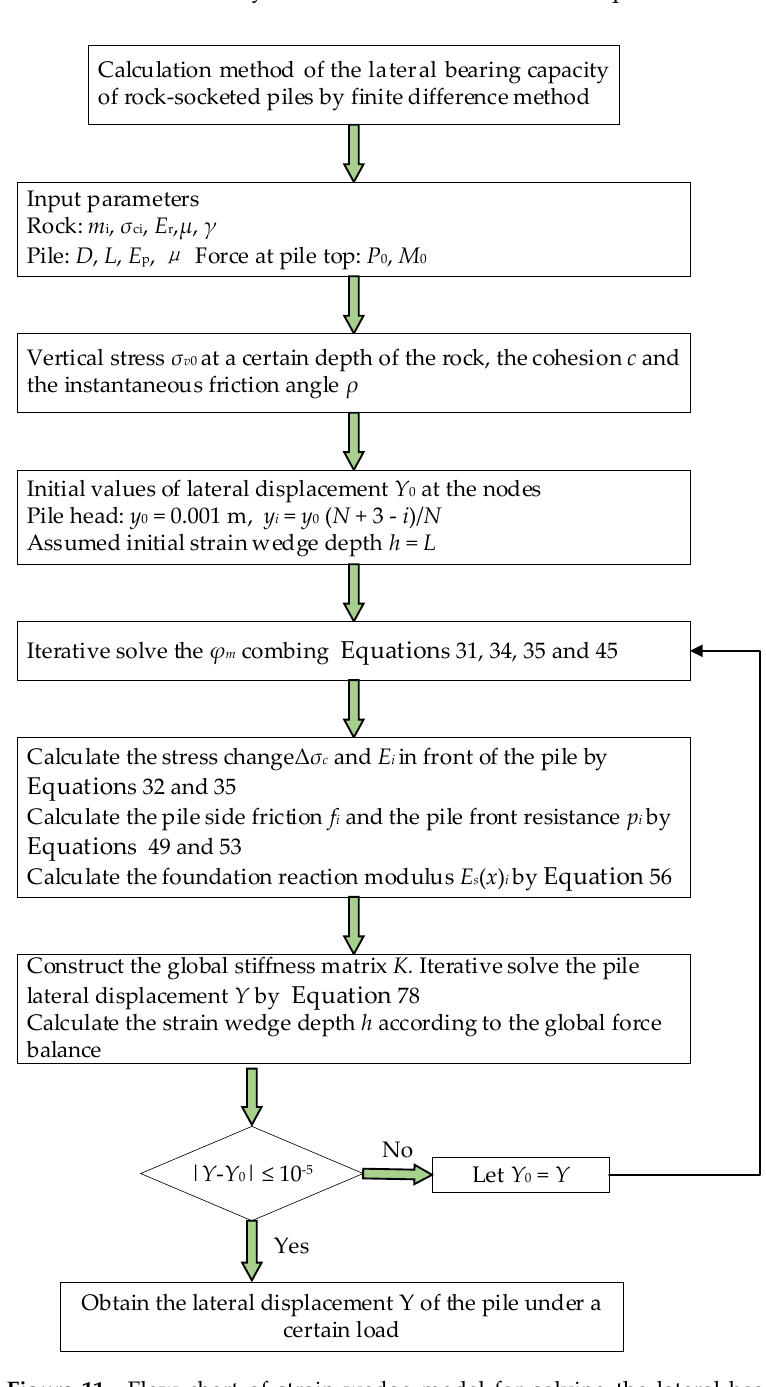
Figure 11. Flow chart of strain wedge model for solving the lateral bearing capacity of rock–socketed piles.